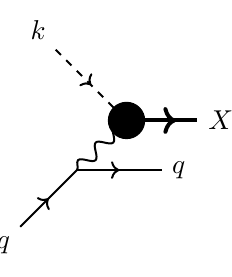
Figure 11 . Feynman diagram corresponding to real radiation of a